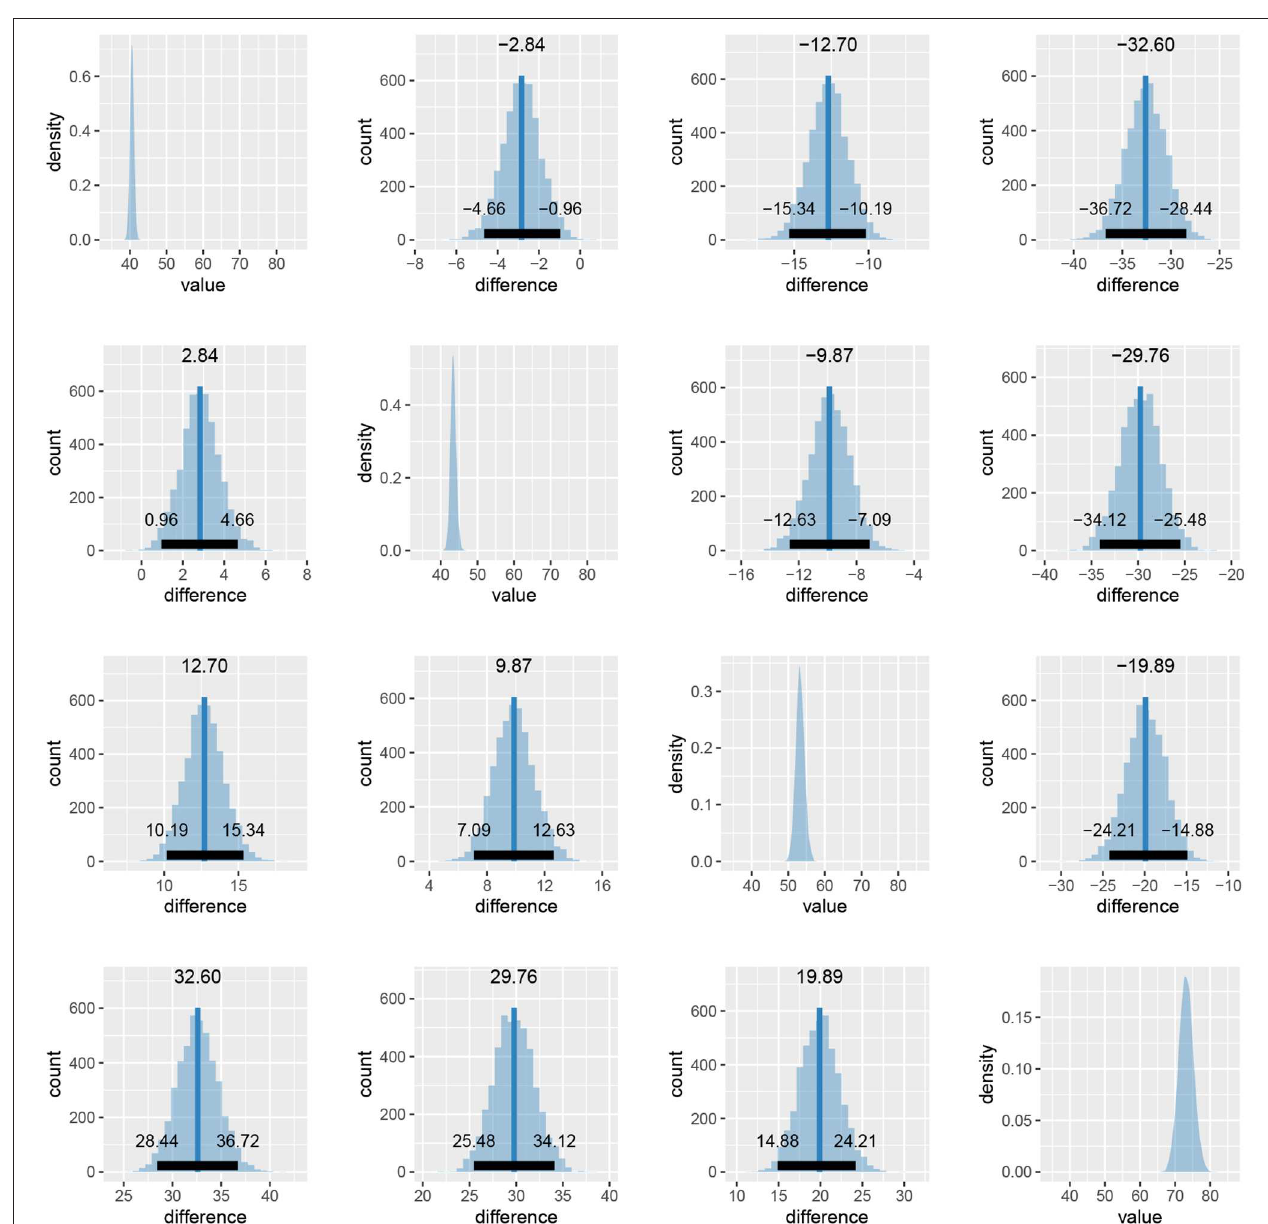
FIGURE 13 | Differences in the mean task completion times for the four conditions. Row and column 1 represent the reading neutral task, row and column 2 the reading incongruent task, row and column 3 the naming neutral task and row and column 4 the naming incongruent task. Since 95% HDI intervals (black bands at the bottom of graphs) in all cases exclude 0 we are confident that the task completion times between conditions are different.